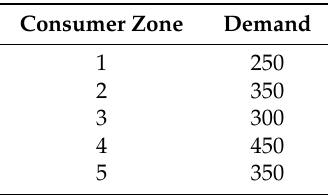
Table 1. Demand of consumer zones (MW).